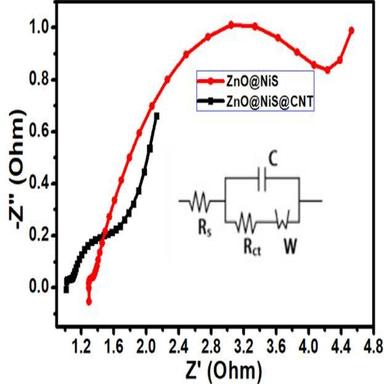
EIS of ZnO/NiS and ZnO/NiS/CNT electrodes over the frequency range of 100 kHz to 0.1 Hz.